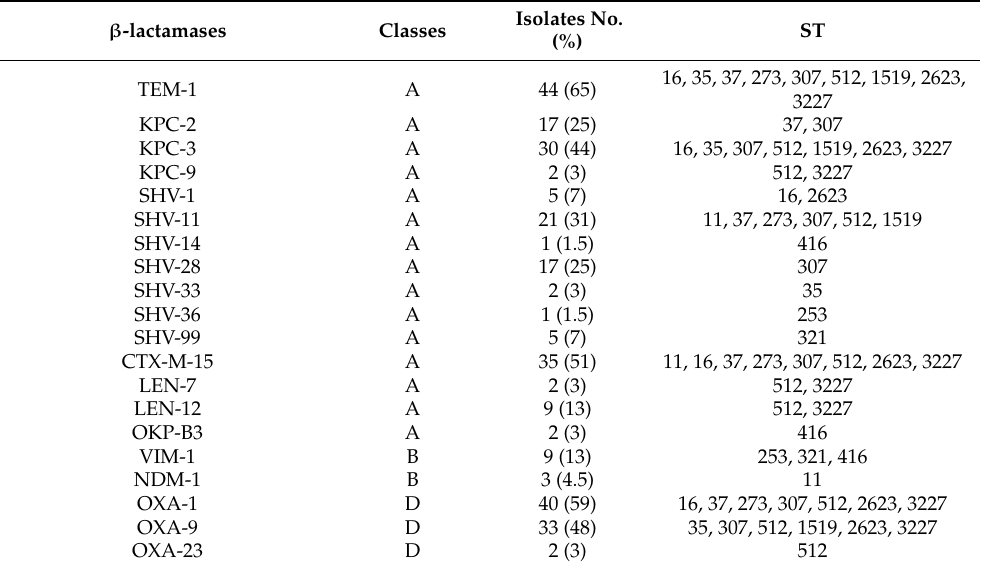
Table 3. Distribution of β -lactamases among K. pneumoniae isolated from residents of 12 LTCFs (Northern